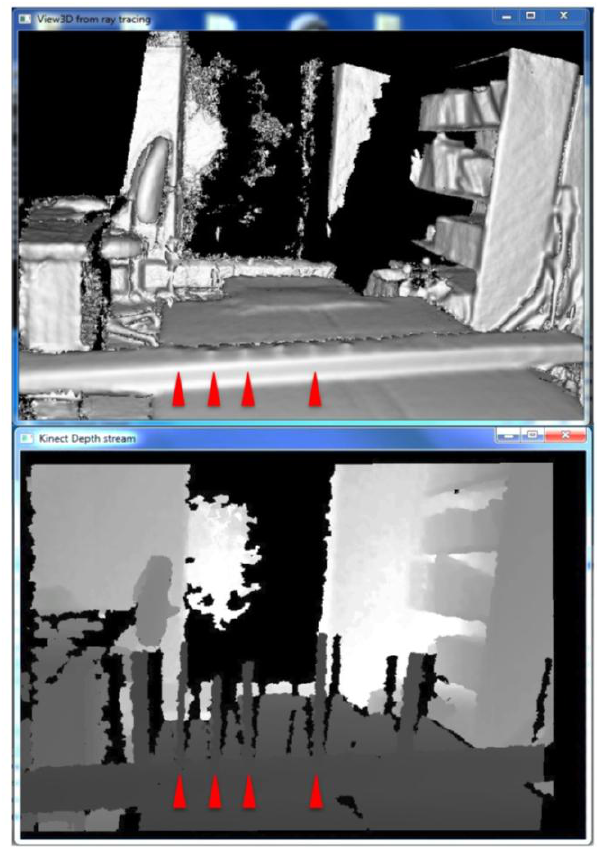
Figure 5. Example of depth stream (top) and resulting mesh (bottom) from the software KinFu and an Asus Xtion 3D camera. Notice that despite the presence of the branches in the depth stream that do not appear in the resulting mesh—suggesting that “filtering” of features of the generated mesh and their tenability will be important for continuous 3D plant scanning. Scanning time was <1